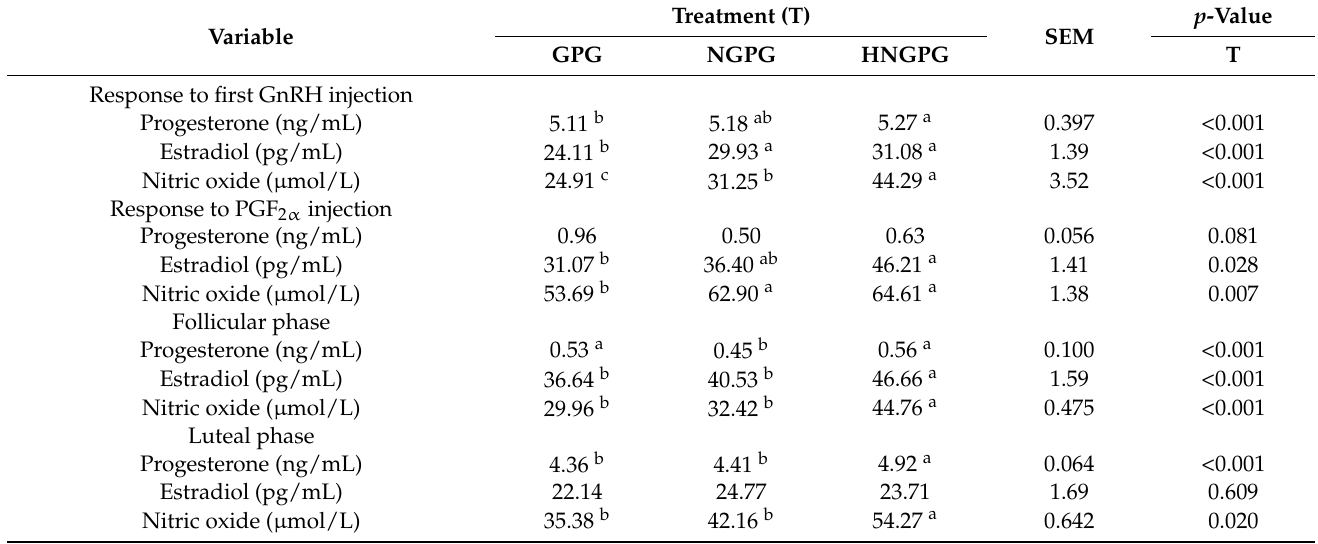
Table 4. Blood serum levels of ovarian steroids and nitric oxide in response to Ovsynch protocol using conventional hormones (GPG: 50 mg gonadorelin and 125 mg cloprostenol) or nanodelivered hormones with different doses (NGPG: 50 mg gonadorelin and 125 mg cloprostenol and